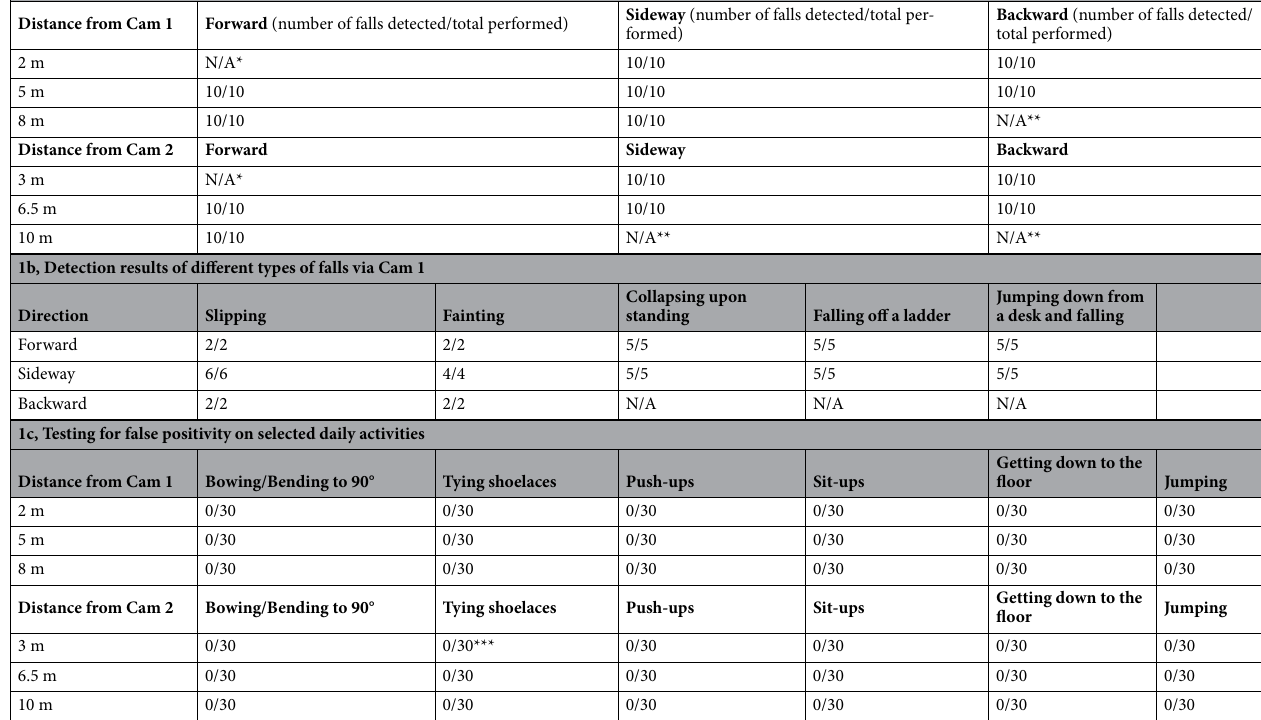
Table 1. Detection results (Number of Falls Detected/Total Performed) of different types of falls and daily activities. *The lower border of the camera formed a 45° angle with the wall on which it was mounted. Installed at an arbitrary height X from the ground, the camera was expected to monitor falls taking place at a horizontal distance of X and beyond. An electronic fence along the lower edge of the viewable area of the camera was built to maximize the detectable area. Any fall hitting the fence would not get detected (e.g., a Forward fall). A second camera in the same room could be used to cover the inactive zone. **Due to the room geometry, Backward and Sideway falls at the long distances would hit the walls and so were not performed. ***Crafted rules were applied (Please see “Discussion”) to distinguish true falls from the activity of Tying shoelaces at a steep downward angle at near